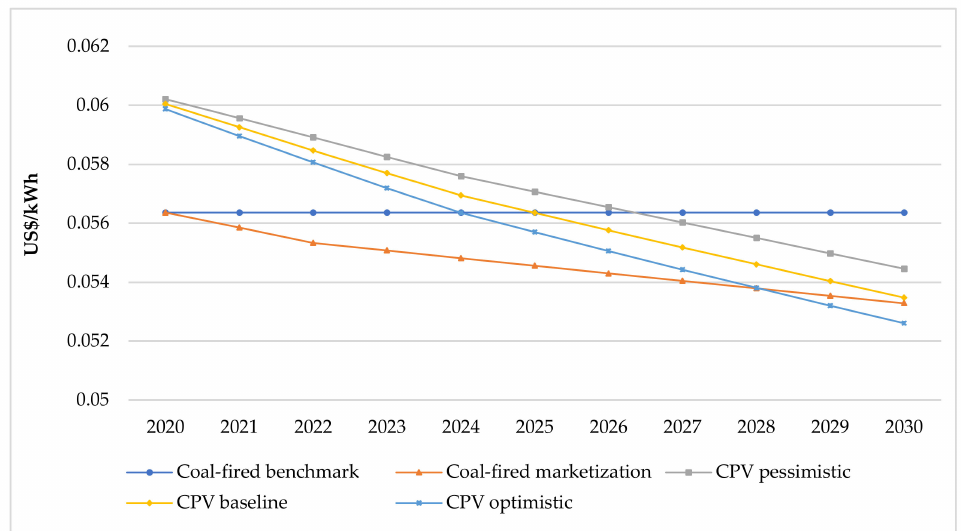
Figure 8. Cost comparison under Scenario